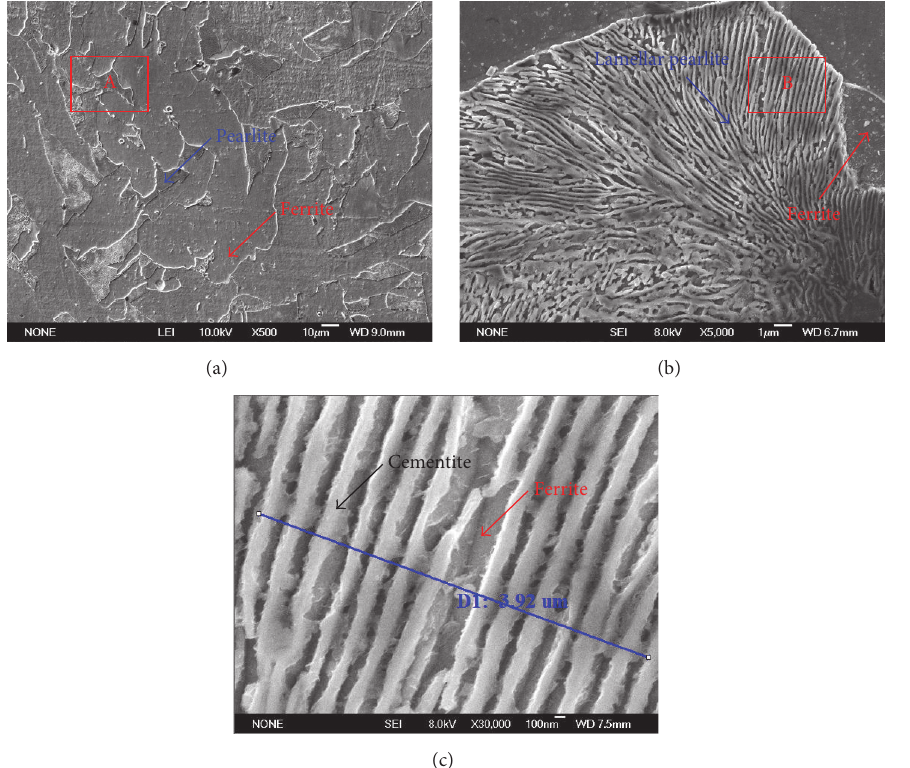
Figure 5: Typical FE-SEM micrographs of the 1045 carbon steel after annealing at 873 K (600 ∘ C) for 6h ((b) is the higher magnification of the A region in (a); (c) is the higher magnification of the 𝐵 region in